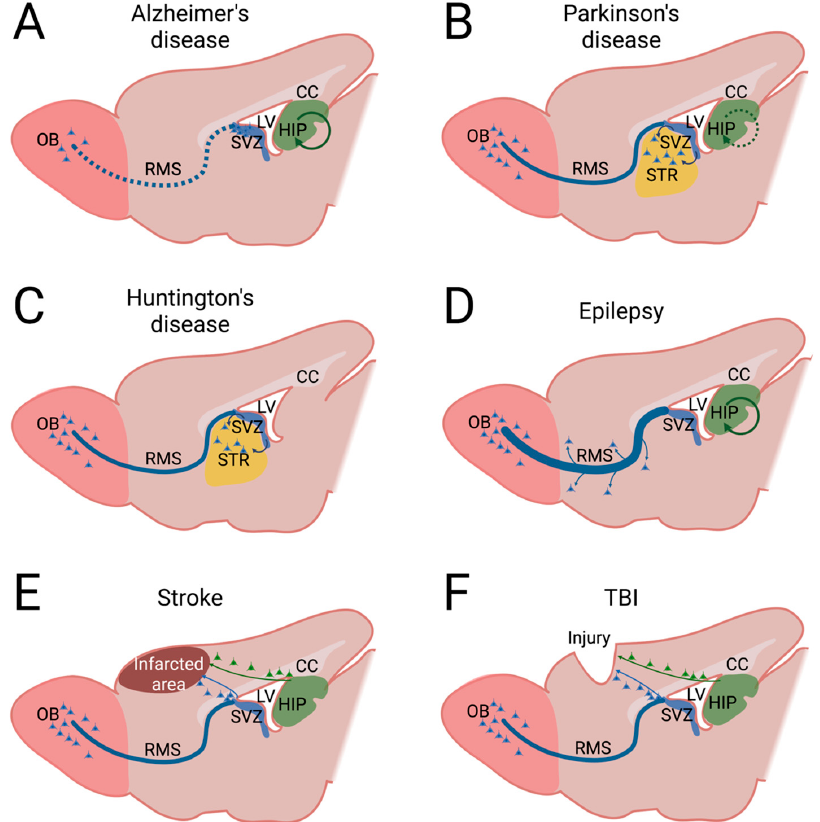
Figure 1. Changes in cell migration in different diseases/injuries. Sagittal view of brains affected by different diseases/injuries and the areas in which migration is altered. Normal arrows indicate the origin and final destination of aberrantly migrating cells; circled arrows represent changes in migration within the same area; dashed lines represent a decreased rate of migration; a thicker line in the RMS (epilepsy) represents an increase in cell migration velocity compared with normal migration within the RMS (Parkinson’s disease, Huntington’s disease, stroke, and TBI). ( A ) Alzheimer’s disease. It has been described as undergoing regional changes within the hippocampus and a detriment to the velocity of migration along the rostral migratory stream, with accumulation of neuroblast in the subventricular zone and fewer neurons in the olfactory bulb. ( B ) Parkinson’s disease. The figure depicts aberrant migration of neuroblast from the subventricular zone to the striatum and retarded migration within the hippocampus. ( C ) Huntington’s disease. As the picture shows, it has been confirmed a clear aberrant migration of neuroblasts from the subventricular zone towards the striatum. ( D ) Epilepsy. As depicted, in different forms of epilepsy, it has been described as aberrant migration within the hippocampus, whereas a higher migration velocity rate has been demonstrated toward the rostral migratory stream, with ectopic migration to non-olfactory areas. ( E ) Stroke. As it can be seen in the figure, after a stroke, the new neuroblasts formed in the subventricular zone and the hippocampus can potentially migrate to the infarcted area. ( F ) Traumatic brain injury (TBI). As represented by the figure, it has been shown that both the subventricular zone and the hippocampus react to the injury, and the new neuroblasts alter their migration patterns, trying to reach the lesion. CC: corpus callosum; HIP: hippocampus; LV: lateral ventricle; OB: olfactory bulb; RMS: rostral migratory stream; STR: striatum; SVZ: subventricular zone; TBI: traumatic brain injury. Created with